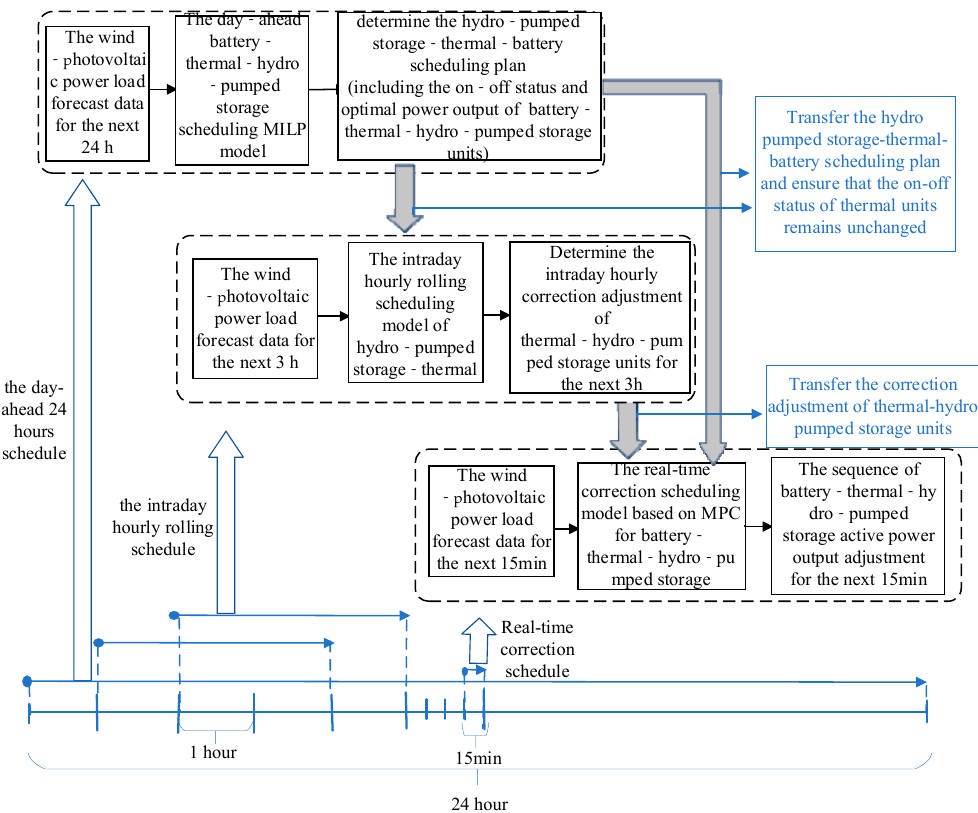
Figure 1. Multi-time-scale coordinated scheduling framework for the combined WPTHB system.